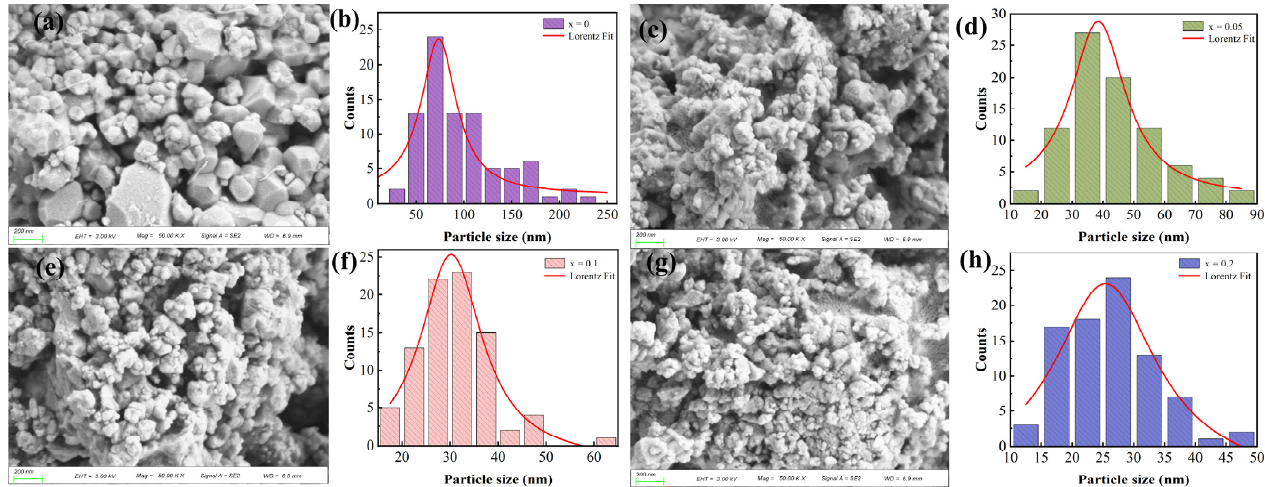
Figure 2. SEM images of Bi 1 − x Er x FeO 3 : ( a ) x = 0, ( c ) x = 0.05, ( e ) x = 0.1 and ( g ) x = 0.2. The size distribution of Bi 1 − x Er x FeO 3 : ( b ) x = 0, ( d ) x = 0.05, ( f ) x = 0.1 and ( h ) x = 0.2.